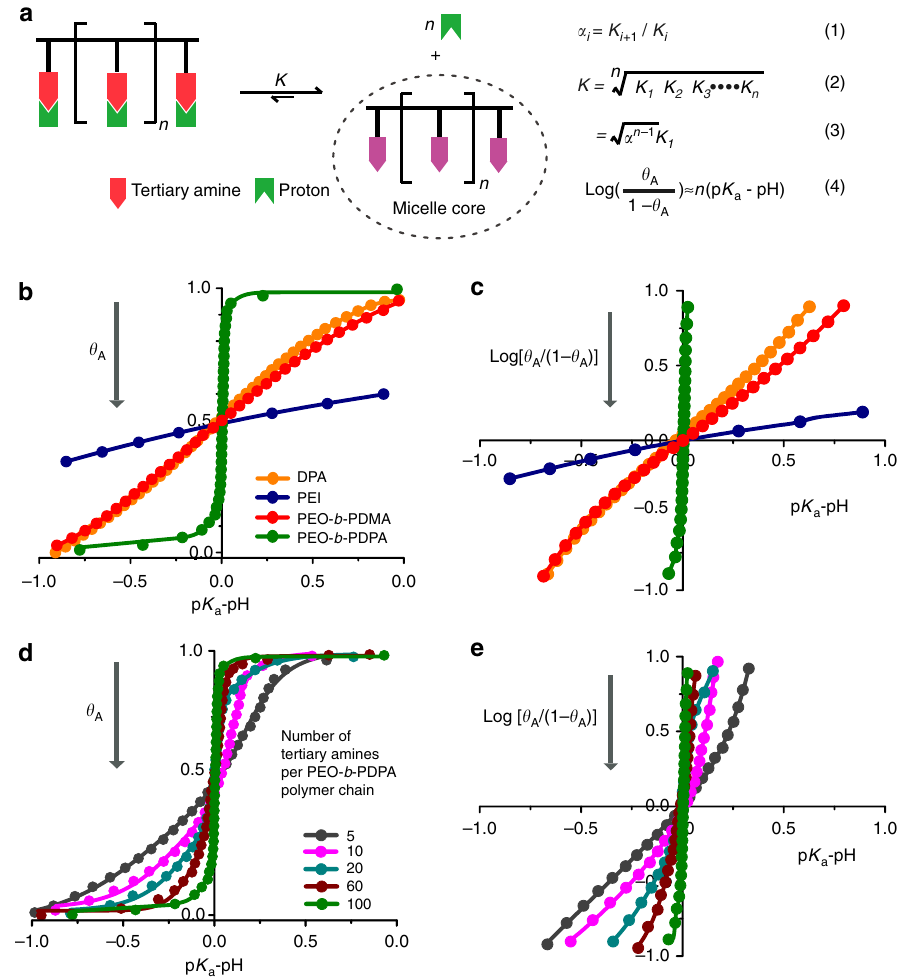
Figure 1 NATURE COMMUNICATIONS|7:13777|DOI: